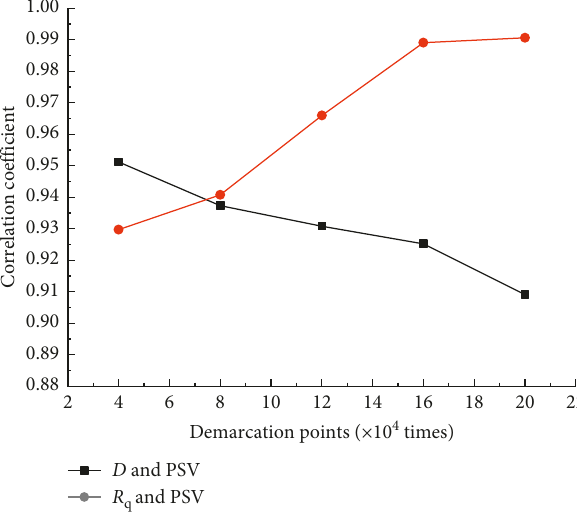
Figure 14: The Pearson correlation coefficient between PSV and D or R q at different demarcation points.